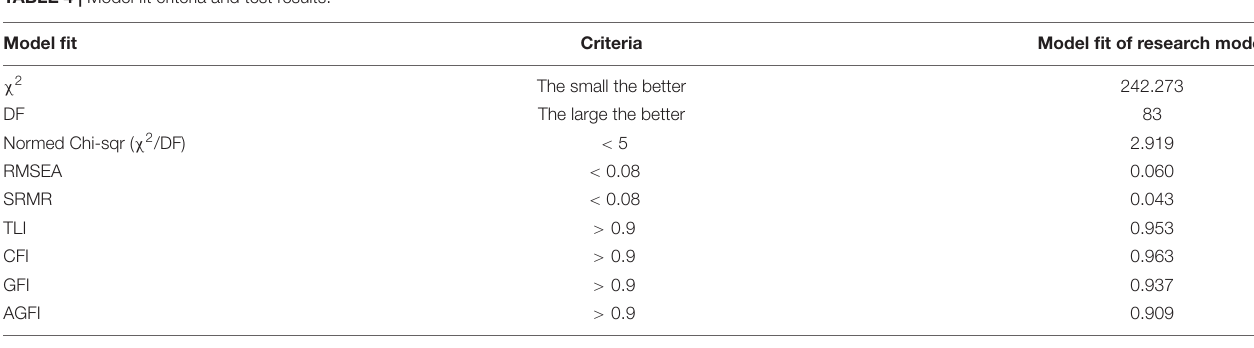
TABLE 4 | Model fit criteria and test results.